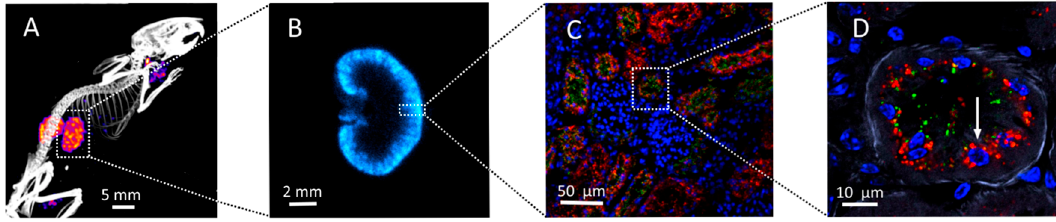
Figure 1. Visualizing the distribution of 125 I-labelled A1M 20 minutes post-injection at different magnification using SPECT/CT ( A ) and digital autoradiography ( B ) at the organ-level and fluorescence imaging showing both A1M ( green ), octreotide ( red ) and cell nuclei ( blue ) ( C , D ) at cellular and sub-cellular levels. The arrow in ( D ) indicates one single cell. The figure is modified from reference 35 with permission from the publisher.